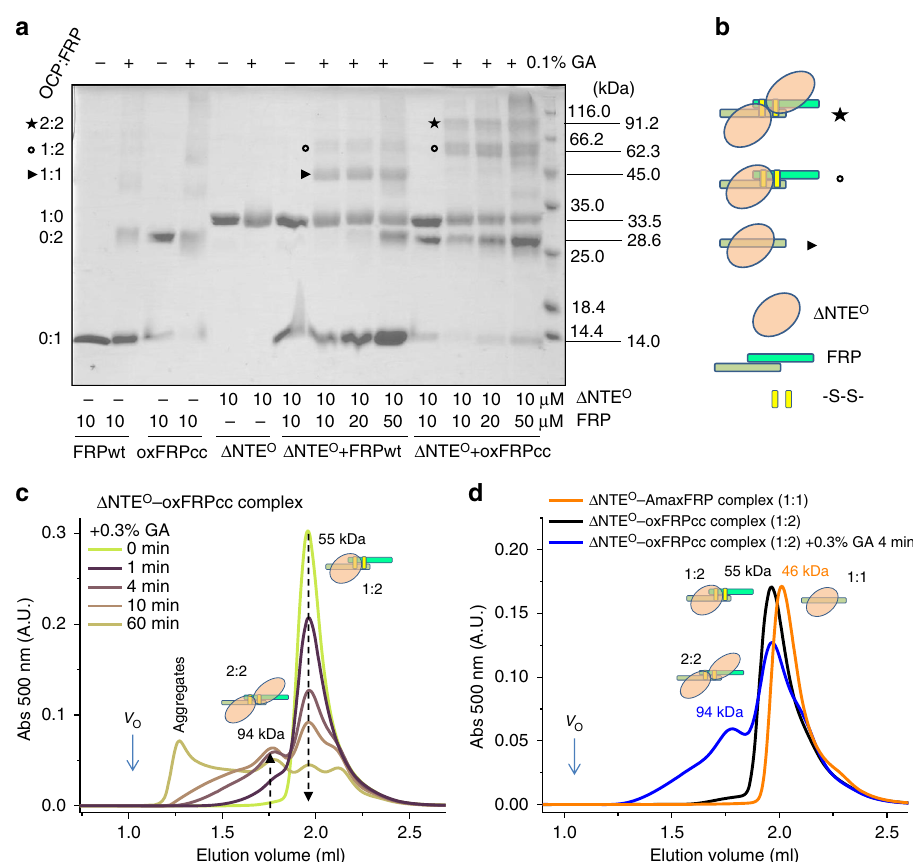
Fig. 4 Stoichiometric analysis of the Δ NTE O – FRP interaction by GA crosslinking. a SDS-PAGE analysis of the results of GA crosslinking of Δ NTE O with either FRPwt, or oxFRPcc, or of individual proteins. Protein concentrations, the presence or absence of GA, M w markers and the contents of the crosslinked samples are shown. The OCP:FRP stoichiometries corresponding to the main bands observed on the gel are given on the left, and the corresponding apparent M w are shown on the right. b Schematic depiction of Δ NTE O (beige oval), the FRP dimer (tints of green) stabilized by disul fi des (yellow bars), and their complexes crosslinked at different stoichiometries, relevant for c and d . Triangle, open circle, and star additionally mark the heterocomplexes with 1:1, 1:2, and 2:2 stoichiometries, respectively. c Kinetics of the crosslinking of the Δ NTE O mixture with oxFRPcc by 0.3% GA ( fi nal concentration) incubated at room temperature and analyzed by SEC on a Superdex 200 Increase 5/150 column upon loading 30 µ l aliquots of the reaction mixture after different incubation times. The decrease of the 1:2 complex peak and a concomitant increase of the 2:2 complex peak are marked by arrows, the void volume is indicated ( V o ). d Chromatograms showing positions of the Δ NTE O – FRP complexes with different stoichiometries. SEC was followed by carotenoid-speci fi c absorbance (500 nm). The Arthrospira homolog of FRP was taken because of its ability to form almost exclusively 1:1 complexes with OCP forms